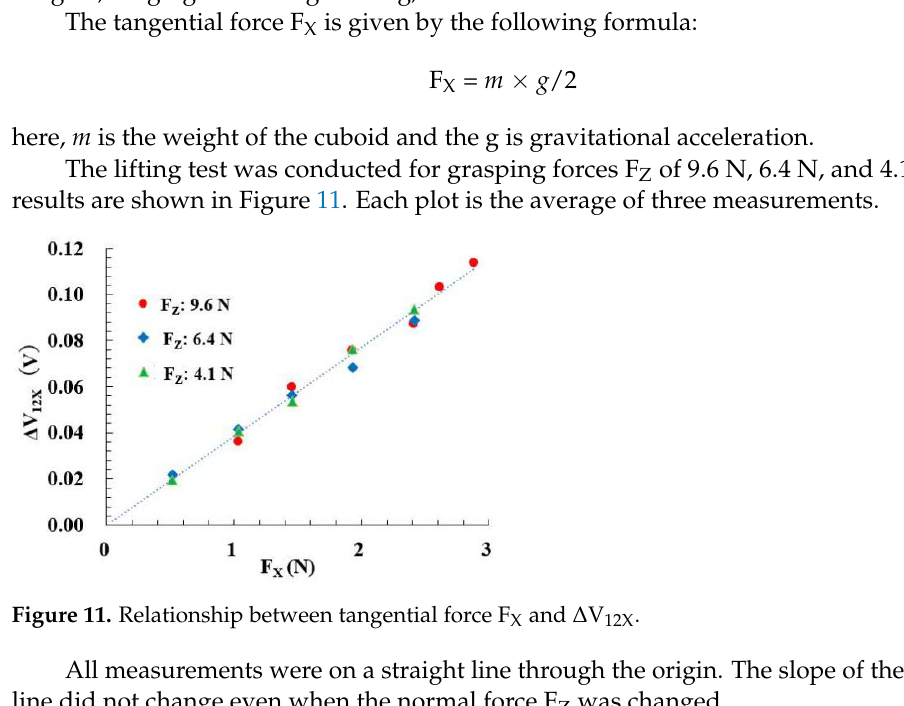
line did not change even when the normal force F Z was changed.